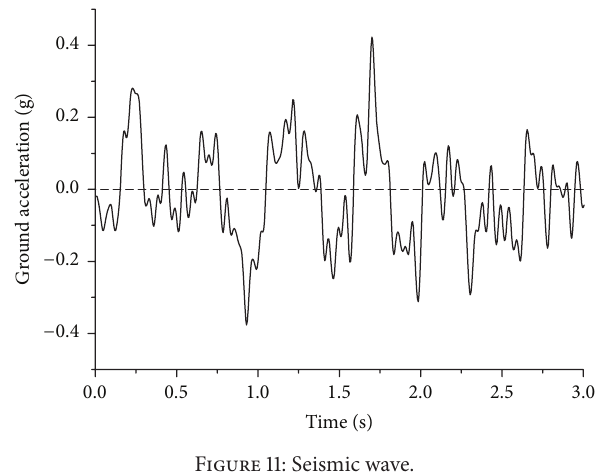
Figure 11: Seismic